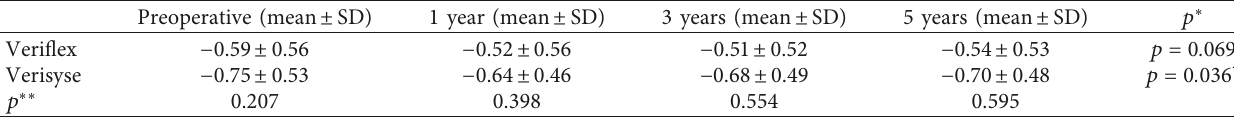
Table 4: Refractive cylinder during follow-up. Preoperative (mean